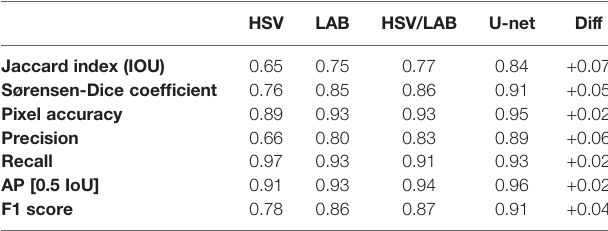
TABLE 3 | Segmentation accuracy of the thresholding methods (HSV only, LAB only, and combined HSV and LAB) and the U-net method and fi nally the difference between HSV/LAB and